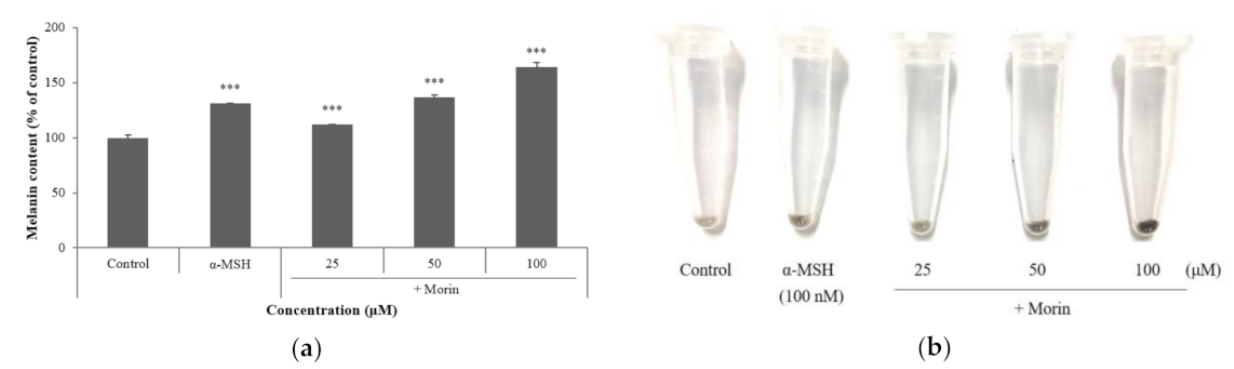
Figure 2. ( a ) Effect of morin on melanin contents. B16F10 mouse melanoma cells were treated with morin (25, 50, and 100 µ M) for 72 h. ( b ) Cell precipitation following centrifugation is indicated; α -MSH (100 nM) was used as the positive control. The data are presented as the mean ± SD of at least three independent experiments; *** p < 0.001 compared with the